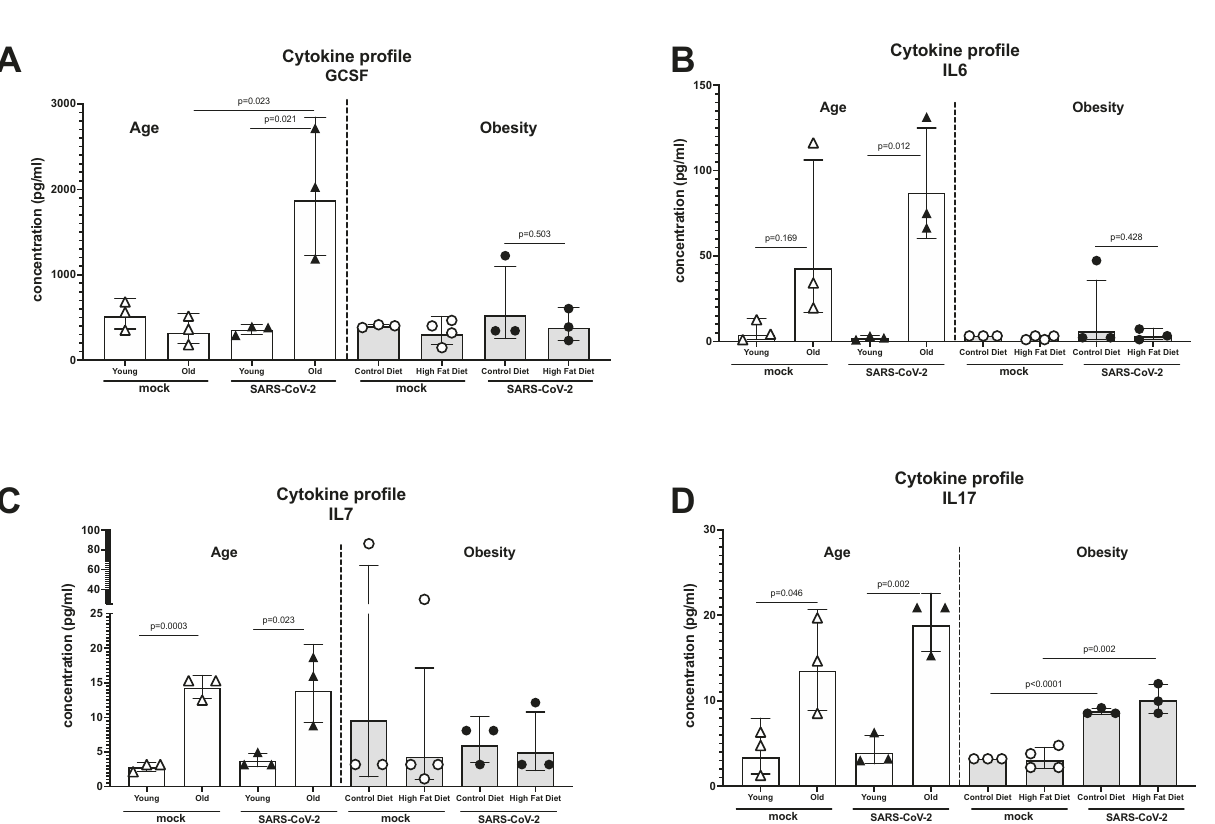
Fig. 7 Cytokine pro fi le in blood of comorbid mice. Young (6 – 8 weeks), old (52 weeks), lean, and obese C57bl/6 mice were infected with 1700 PFU of MA- SARS-CoV-2. Blood was collected at 5 days post-infection ( n = 3) and cytokine levels were quanti fi ed by luminex multiplex ELISA. Levels for GCSF ( A ), IL6 ( B ), IL7 ( C ) and IL17 ( D ) are shown. Two-sided Unpaired t -test was performed to calculate the statistical signi fi cance between different groups. Bars represent geometric means; error bars represent standard deviation. Each data point corresponds to individual mouse and the number of data points represents the number of mice in the corresponding groups. Source data are provided as a Source Data fi